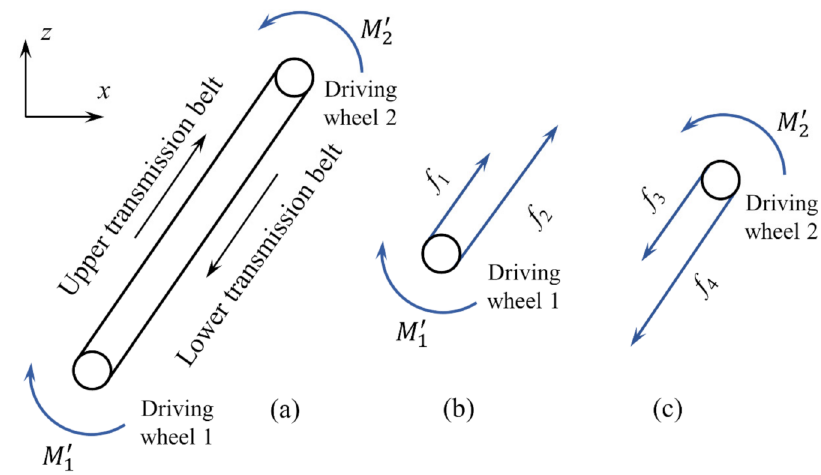
Figure 4. Force analysis of transmission system: ( a ) The force of a single transmission belt and the matching driving wheels; ( b ) The force of the driving wheel 1; ( c ) The force of the driving wheel